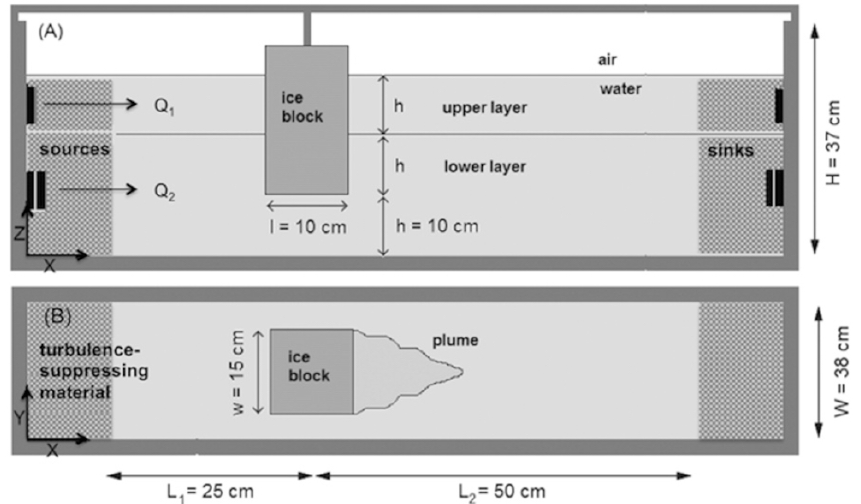
Figure 8. Side ( A ) and top ( B ) view of the experimental setup for two-layered vertically sheared flow experiments with a suspended ice block. Reproduced from [136], with permission from the American Meteorological Society,